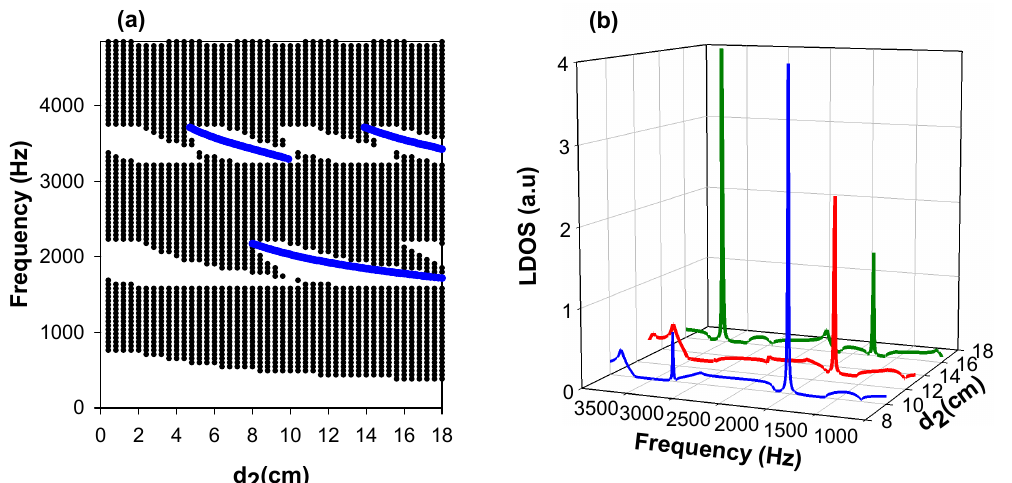
Figure 5. ( a ) Projected bandgap structure as a function of the period of the second PnC of length d 2 and a fixed period of the first PnC d 1 = 2 cm. The lengths of the stubs are assumed to be similar = d (cid:48) = 10 cm). Shaded areas represent bulk bands, while white areas display common bandgaps ( d (cid:48) 2 1 between the two PnCs. Blue branches represent interface Tamm states inside the common bandgaps obtained by the maxima of LDOS. ( b ) Examples of LDOS spectra as a function of frequency for three values of d 2 : d 2 = 10 cm, d 2 = 13 cm and d 2 = 16